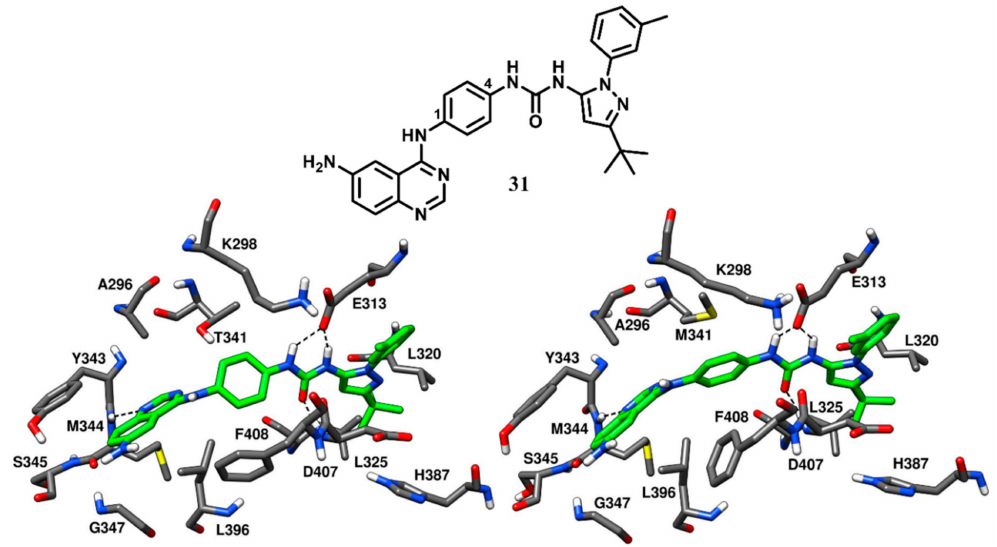
Figure 24. X-ray structure of wild type c-Src (PDB ID: 3F3V) and drug-resistant c-Src (PDB ID: 3F3W) in complex with 31 . Active site residues of c-Src kinase and the enzyme–inhibitor H-bond interactions are